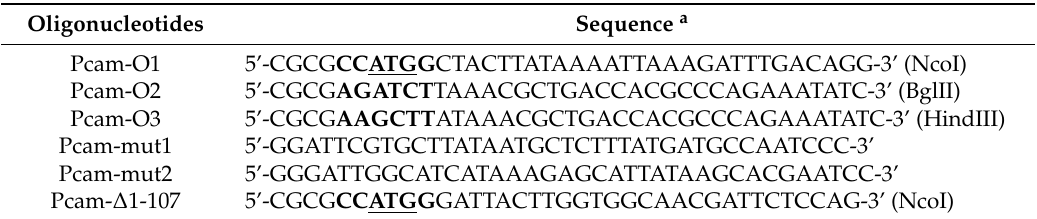
Table 3. Oligonucleotides used in this